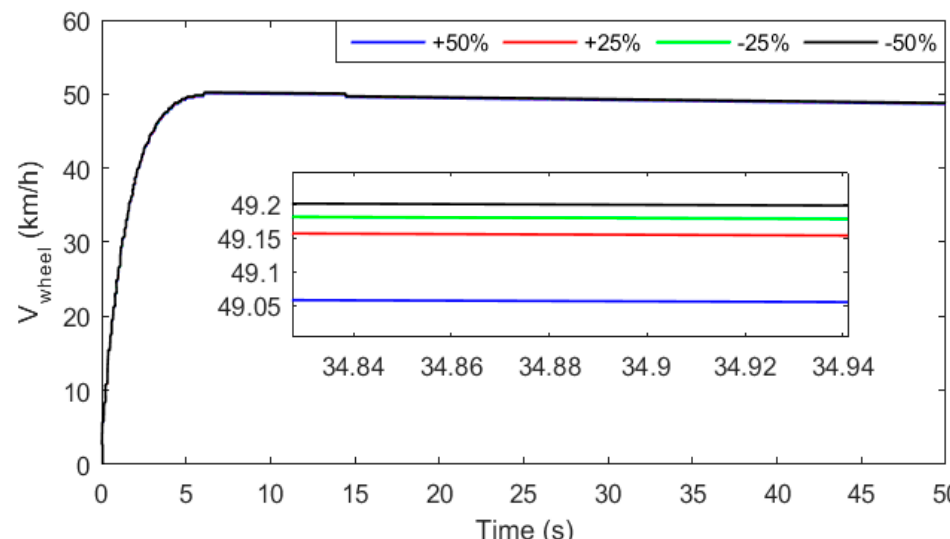
Figure 42. Effect of inverter time constant variation.